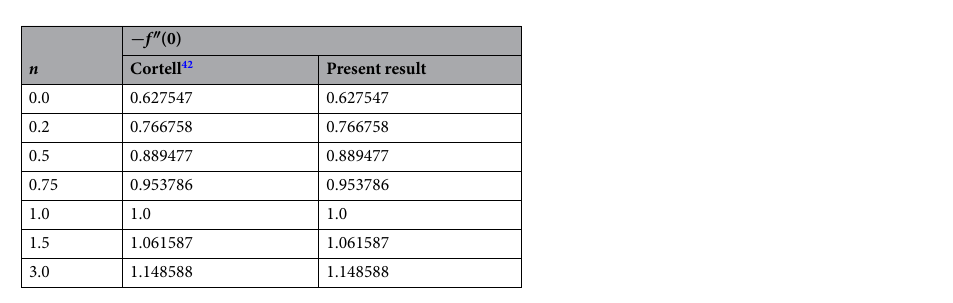
Table 3. Comparison of − f ″ (0) with 42 for various values of n in the absence of the micropolar nanofluid and h-h reactions when M = 0 = φ = λ .